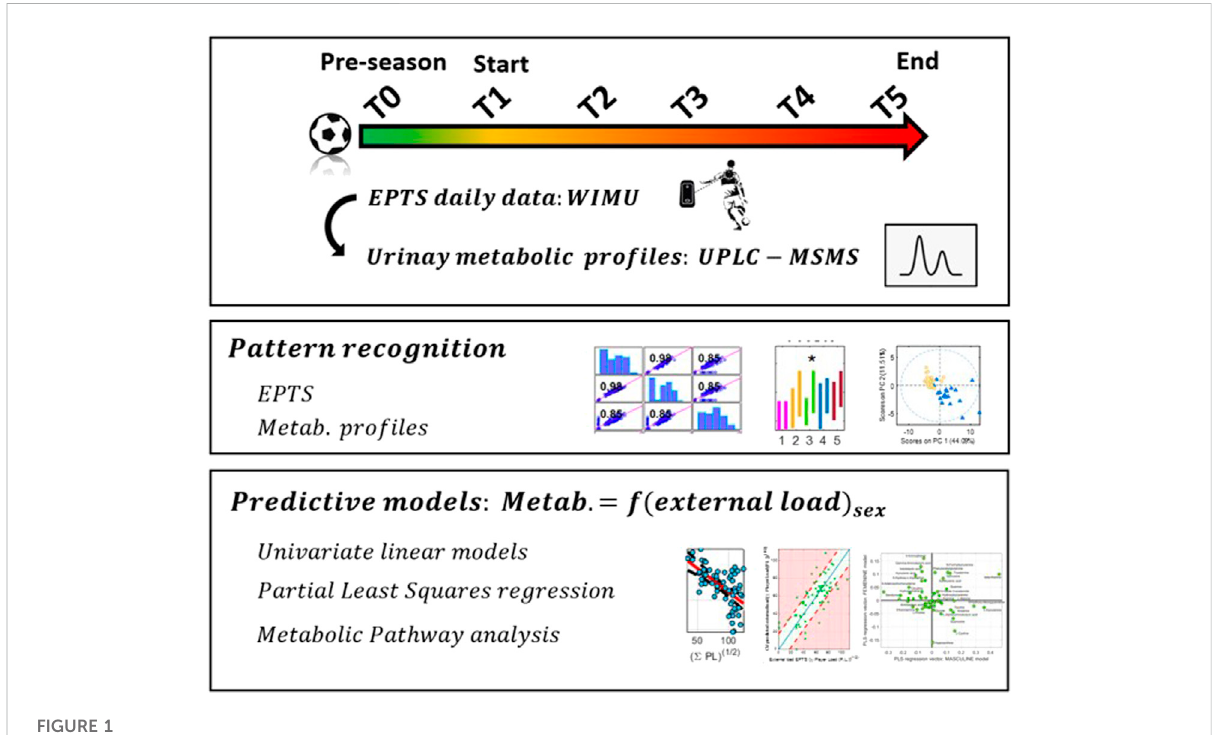
FIGURE 1 Scheme of the